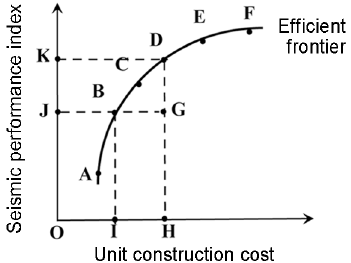
Fig. 3. School building planning efficiency